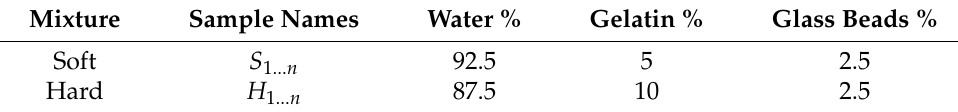
Figure 2. The dimensions of the specimen with inclusion. The homogeneous samples had the same outer dimensions, except that the inclusion was omitted. Table 1. The ingredients of the gelatin mixtures given in percentage by